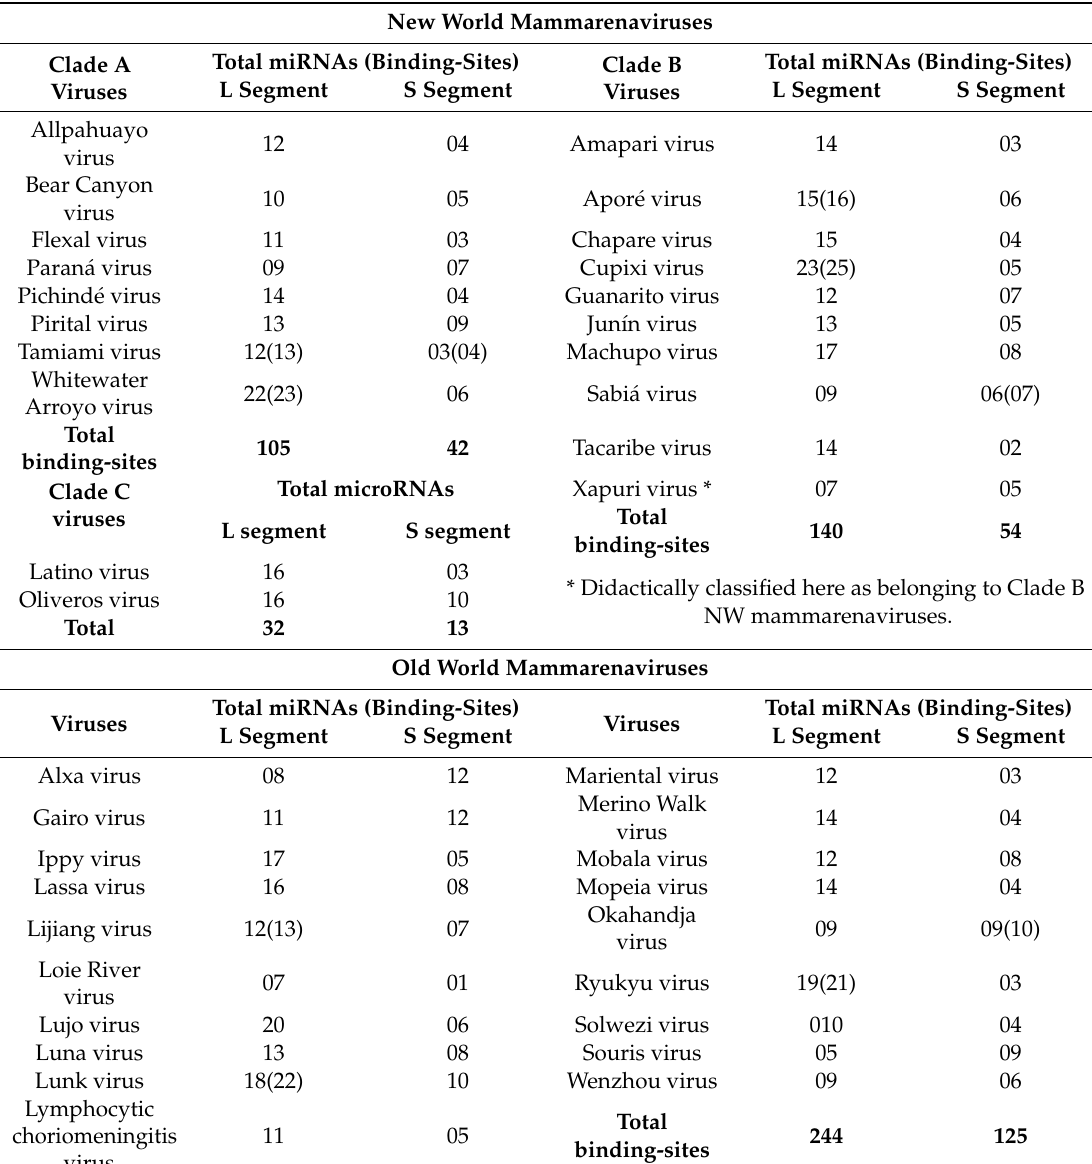
Table 1. Total miRNAs found with the potential to bind to mammarenavirus